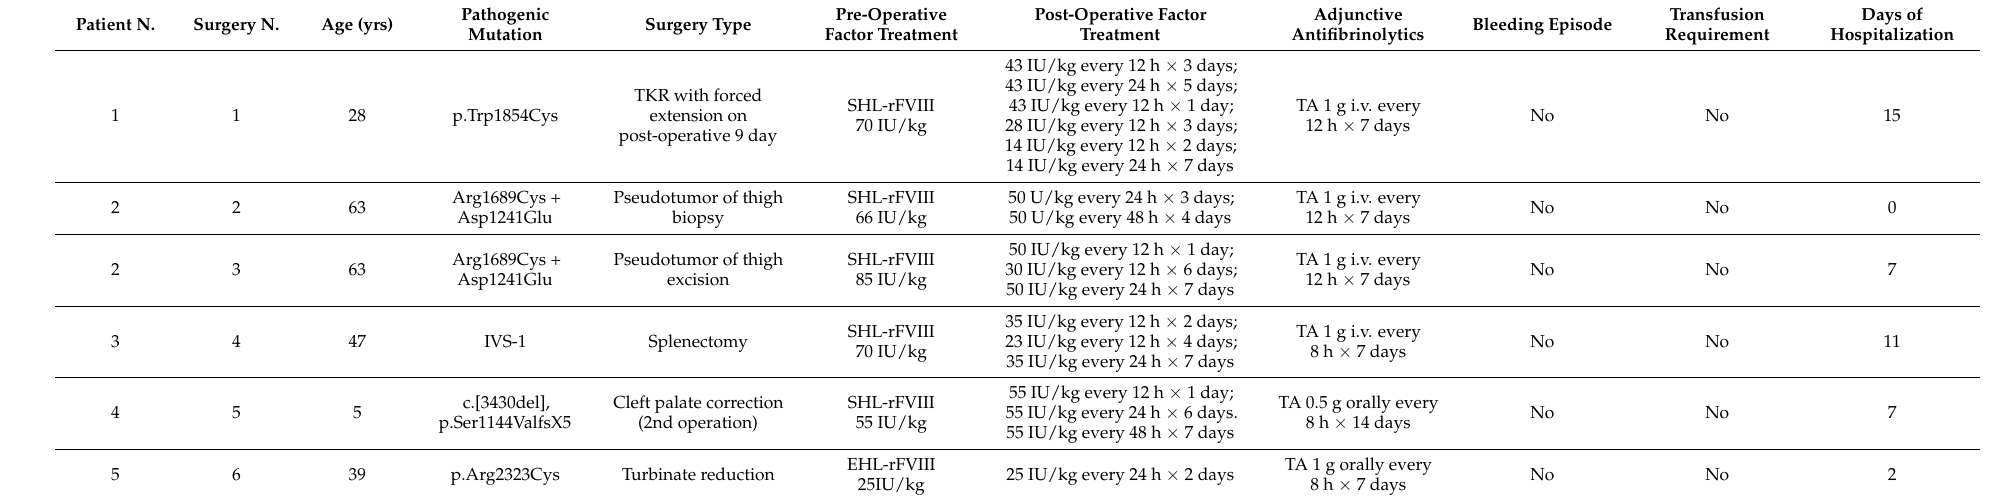
Table 3. Major surgeries in PWSHA without inhibitors. Patient N.